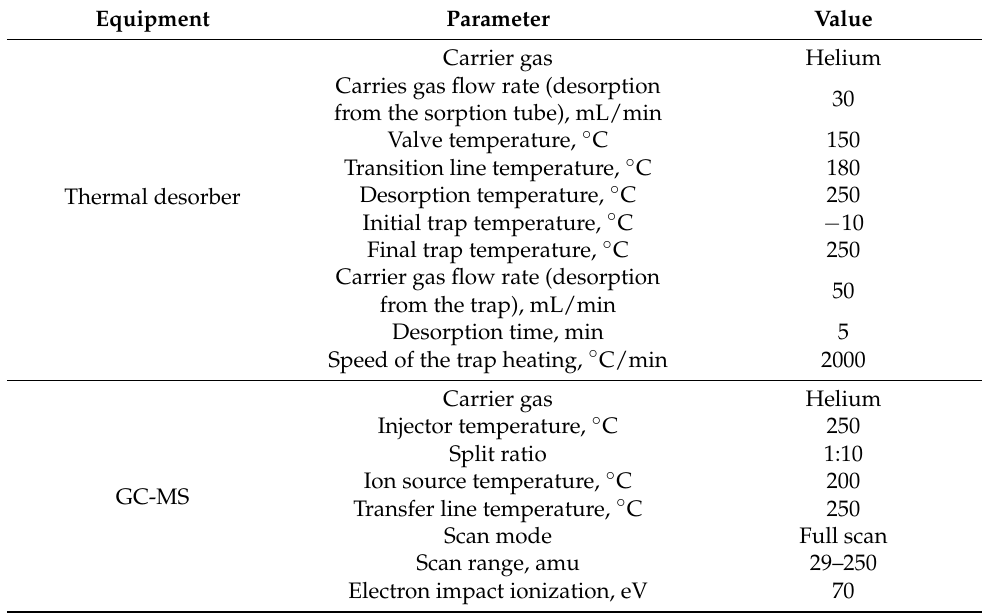
Table 2. Thermal desorber and GC-MS operation